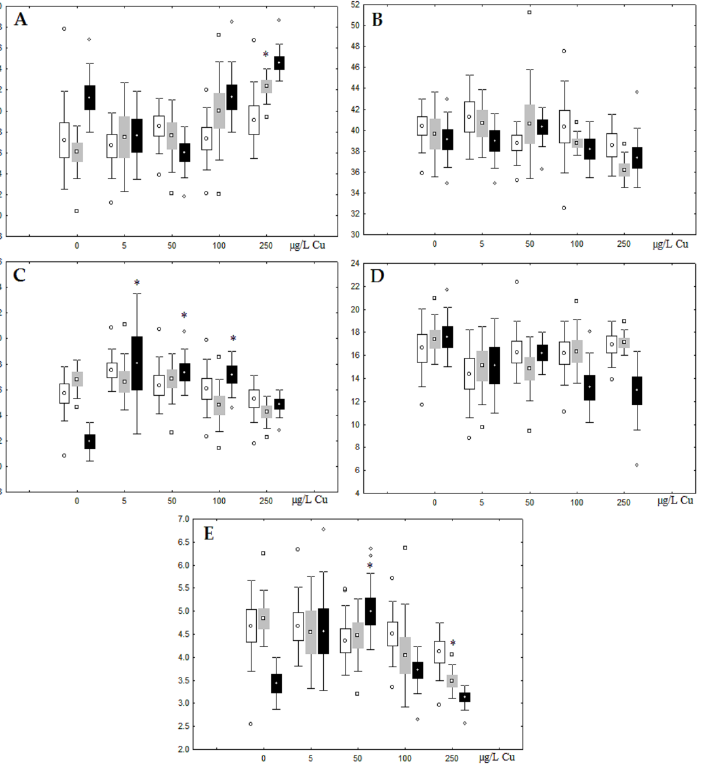
Figure 8. Changes in the ( A ) sum of saturated fatty acids, ( B ) monounsaturated fatty acids, ( C ) n-3 polyunsaturated fatty acids, ( D ) n-6 polyunsaturated fatty acids, and ( E ) unsaturation index in phospholipids of digestive glands of A. cygnea under experimental copper effects: white box – day 1 of the experiment; grey box – day 3 of the experiment; black box – day 7 of the experiment. * – significant results in comparison with control (0 µg/L Cu). Differences were estimated using the nonparametric Kruskal – Wallis test; p < 0.05.